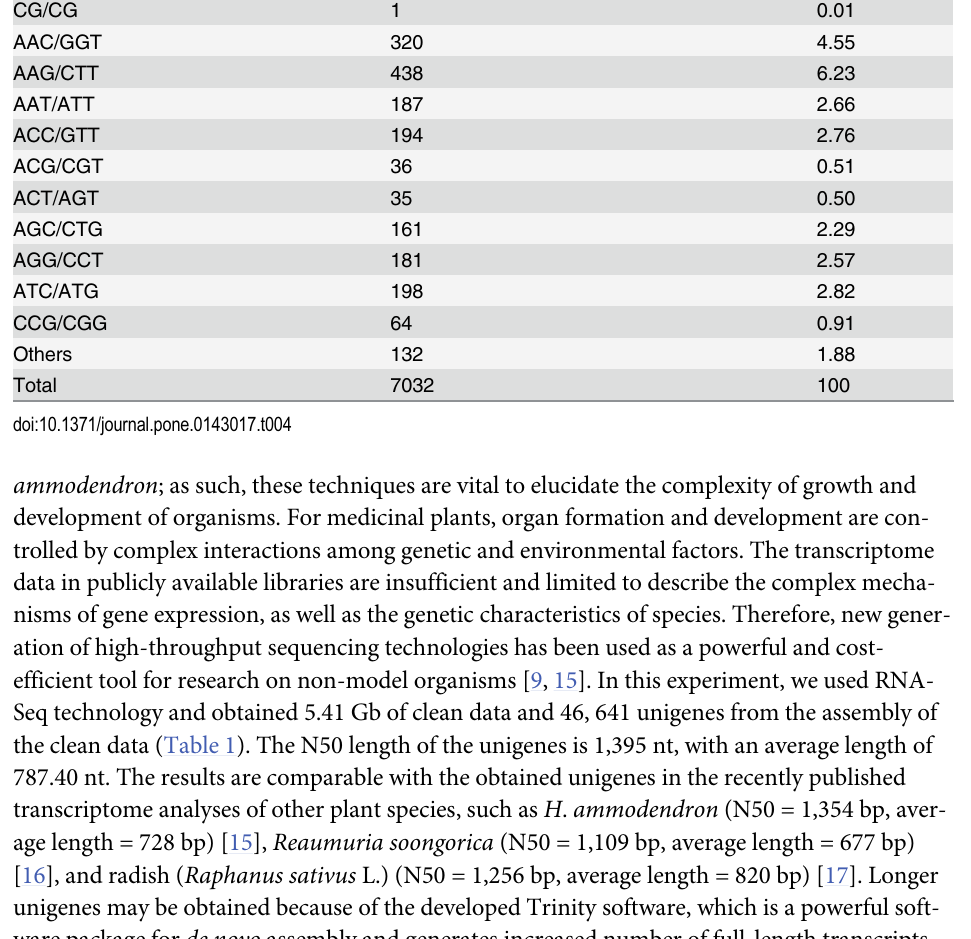
PLOS ONE | DOI:10.1371/journal.pone.0143017 November 16,